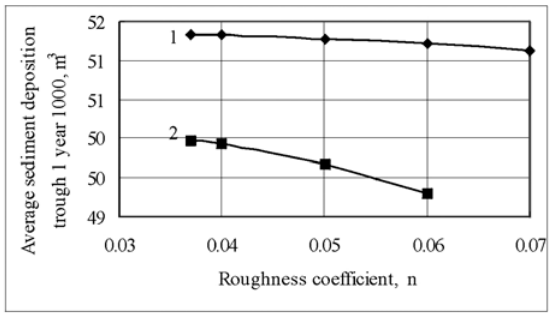
Fig. 12. The influence of the transverse road bank existence and the growing of bushes or tree strips in the valley on sediment deposition in the valley, when: 1 – the transverse road bank is absent; 2 – the bank